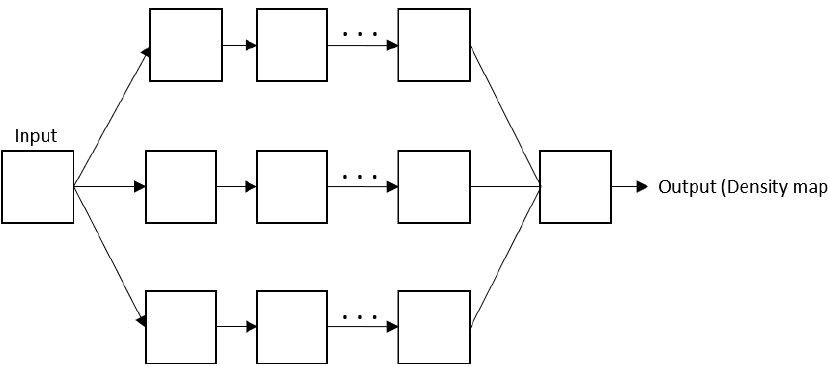
Figure 5. Overall architecture of the multi-column